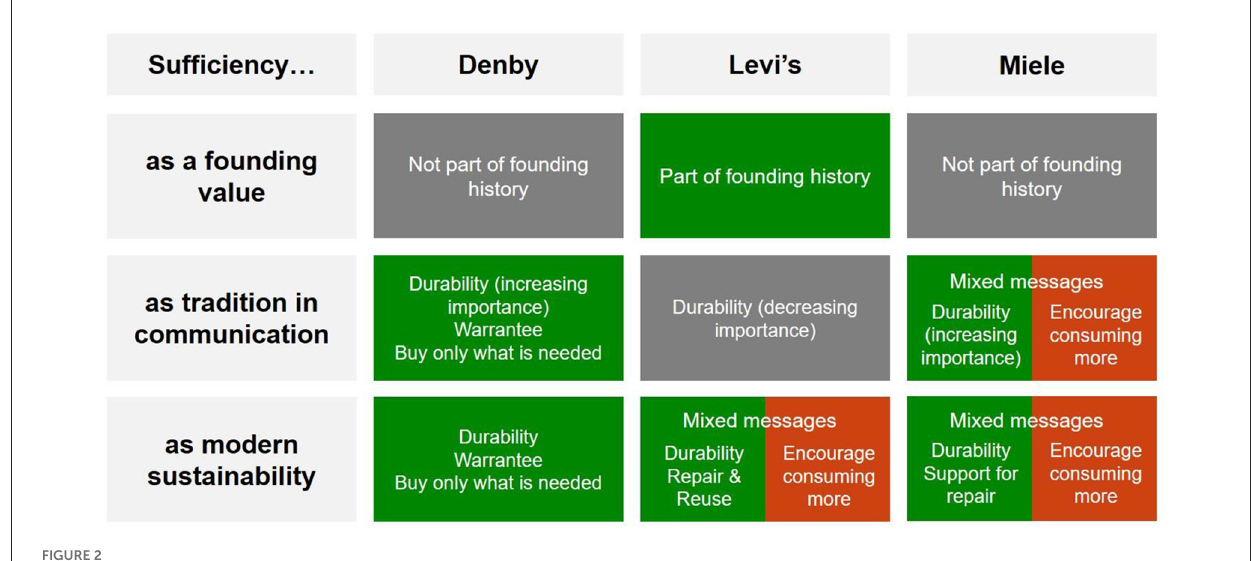
FIGURE2 Sufficiency as trend or tradition in the case businesses.